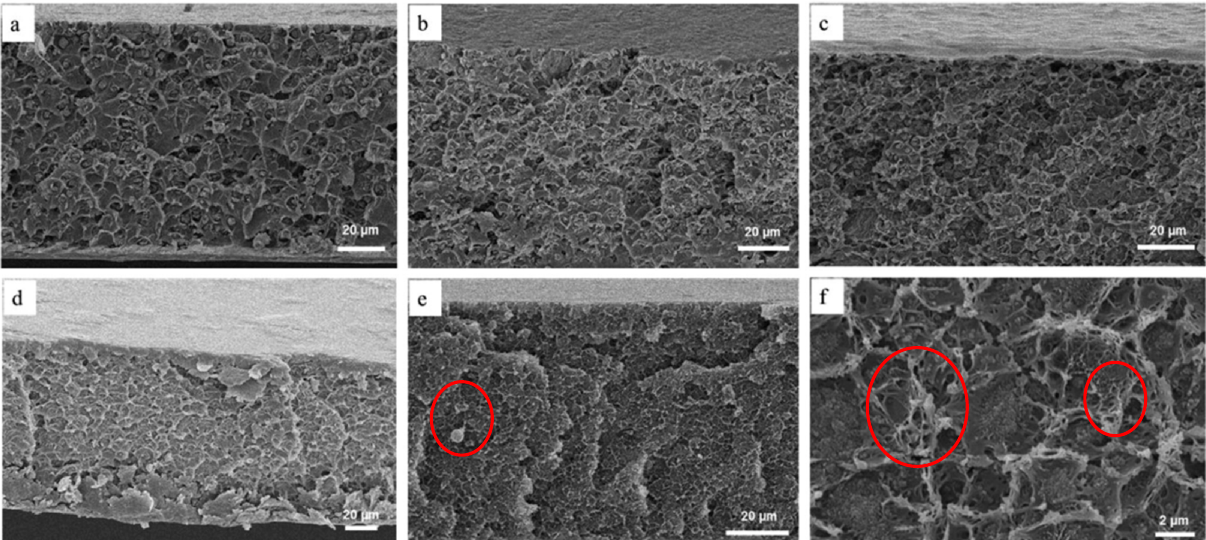
Figure 3. Cross-sectional SEM images of Matrimid with different filler loadings: ( a – c ) MIL-125 loading of 5%, 15%, and 30%, respectively, and ( d – f ) NH 2 -MIL-125 loadings of 5%, 15%, and 30%, respectively